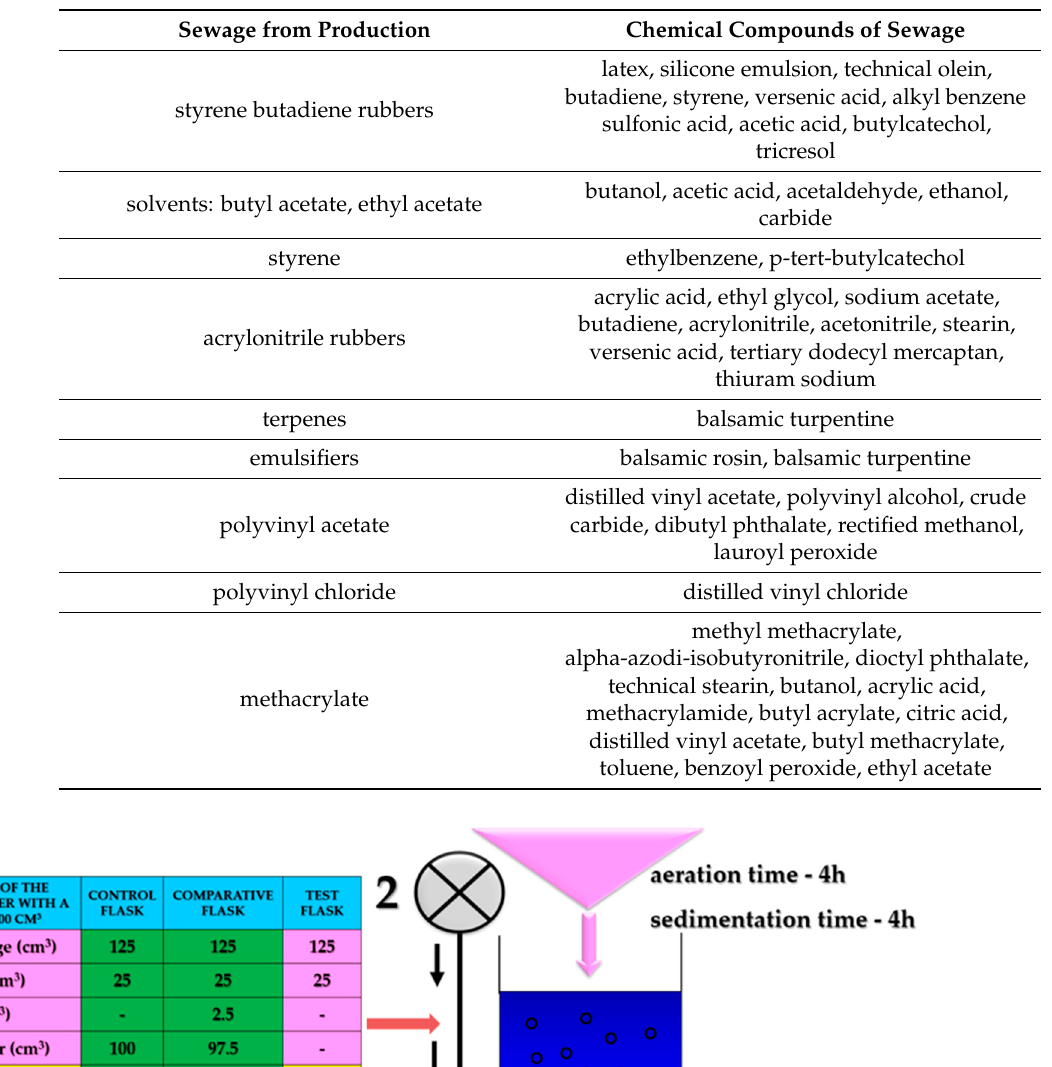
Table 1. Chemical composition of the analysed wastewater.